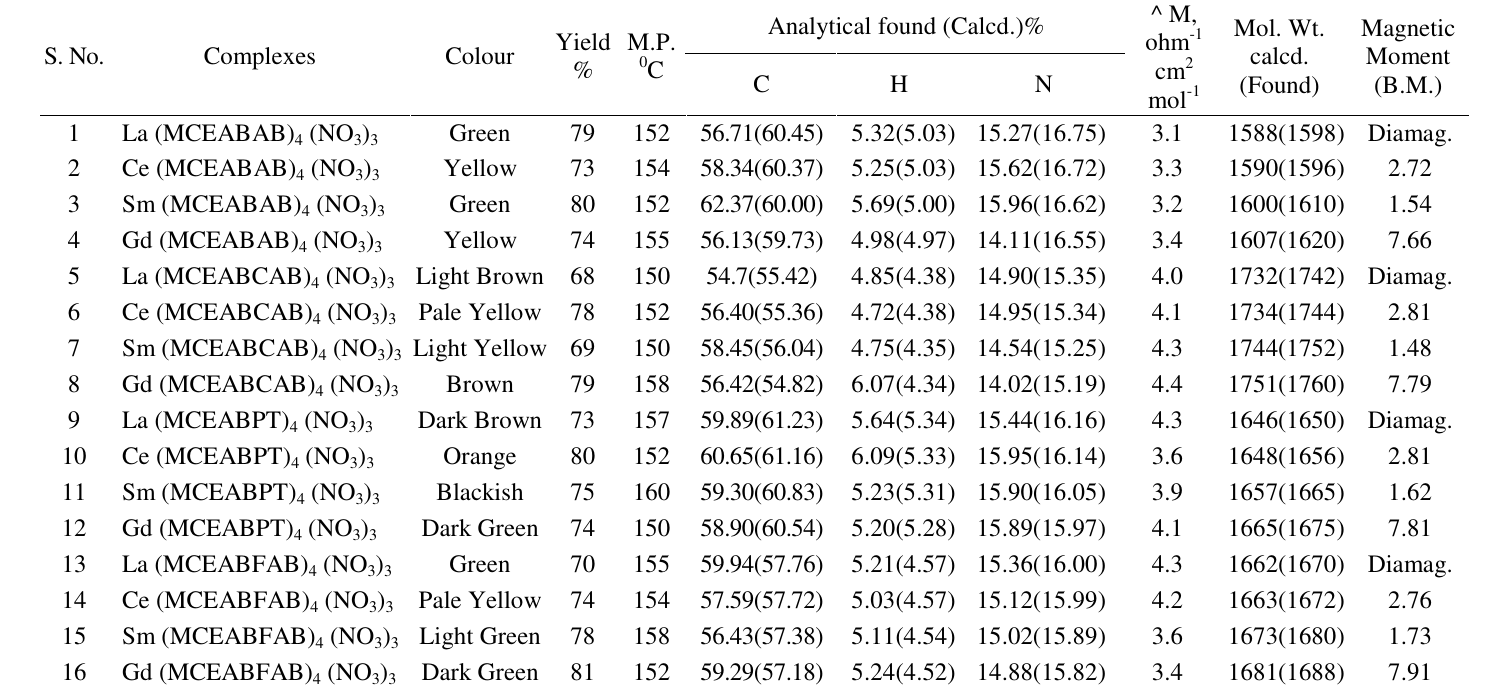
Table 2. Analytical, conductance, molecular weight and magnetic moment data for lanthanide(III) nitrate complexes of Schiff base ligands under